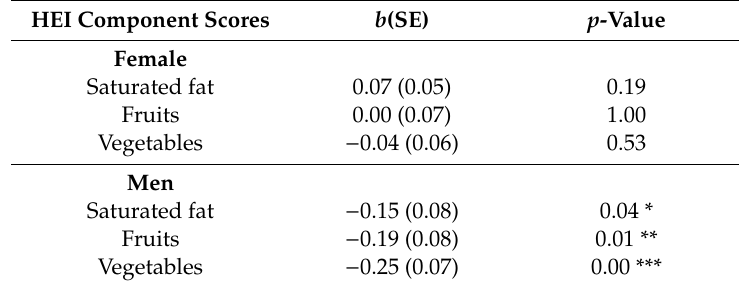
Table 6. Sex differences in the relationship between depression and food choices (Hypothesis 4b).